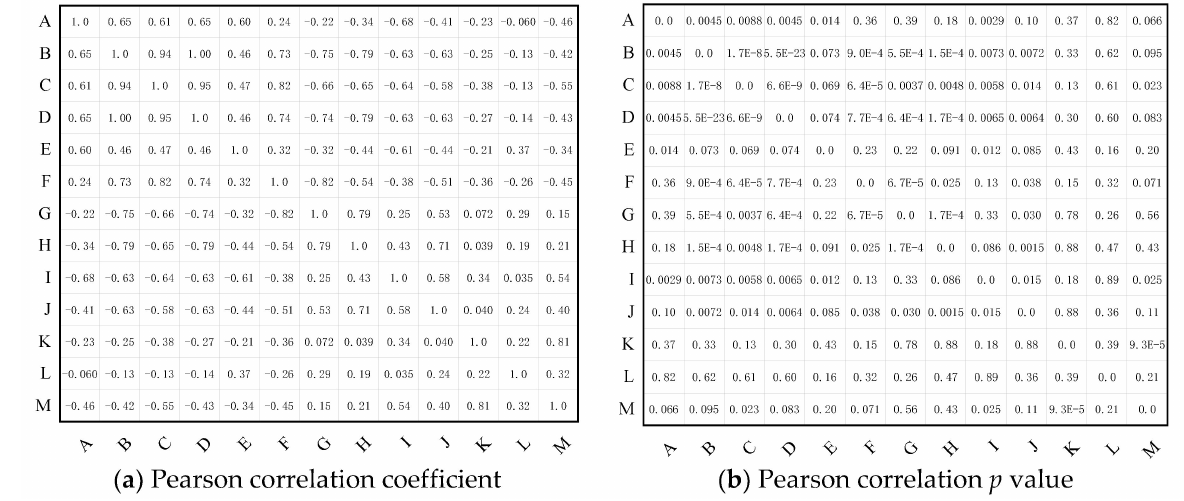
Figure 11. The Pearson correlation analysis between XLPE characteristic parameters. A—service time (year), B—melting temperature ( ◦ C), C—initial melting temperature ( ◦ C), D—lamellar thickness (nm), E—carbonyl index, F—crystallinity (%), G, H—crystallize interplanar spacing of (110) (220), I—electrical breakdown strength (kV/mm), J—elongation at break (%), K—low frequency dielectric constant, L—low frequency dielectric loss, M—low frequency loss